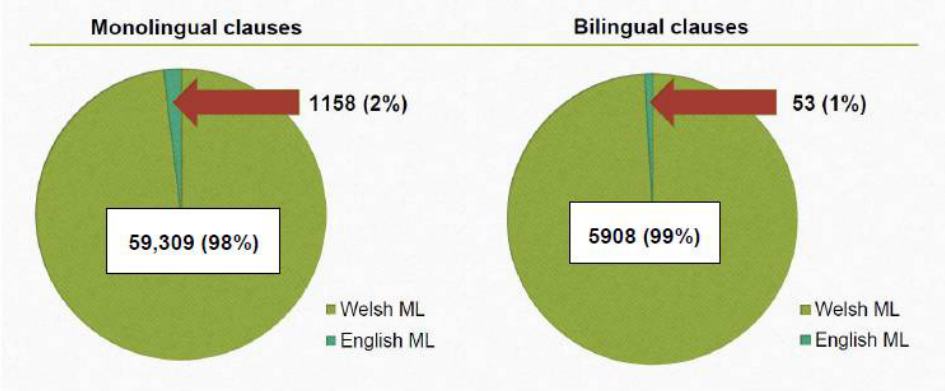
Figure 5. Quantitative distribution of matrix language in Siarad corpus.